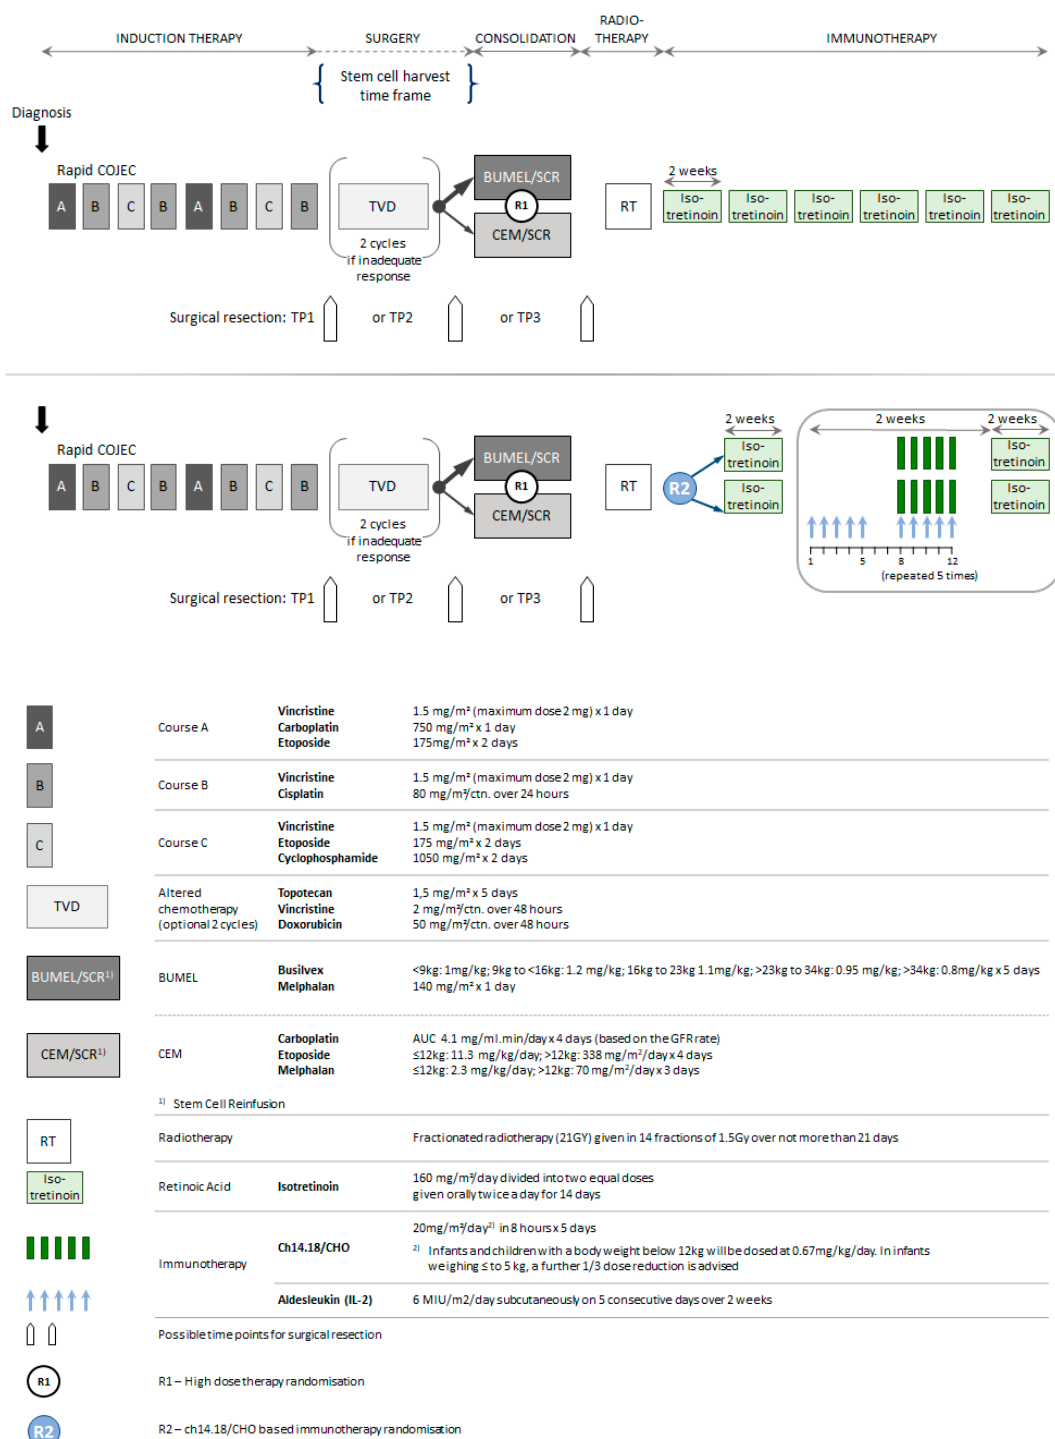
Figure 4. HR-NBL1/SIOPEN treatment overview. Figure 4. HR-NBL1 / SIOPEN treatment